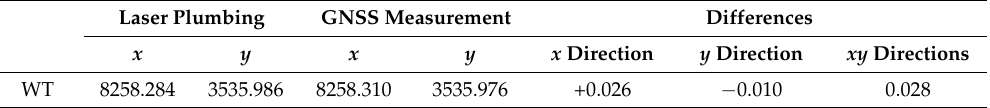
Table 9. Differences between the coordinates of the laser plumbing and GNSS measurements (m).